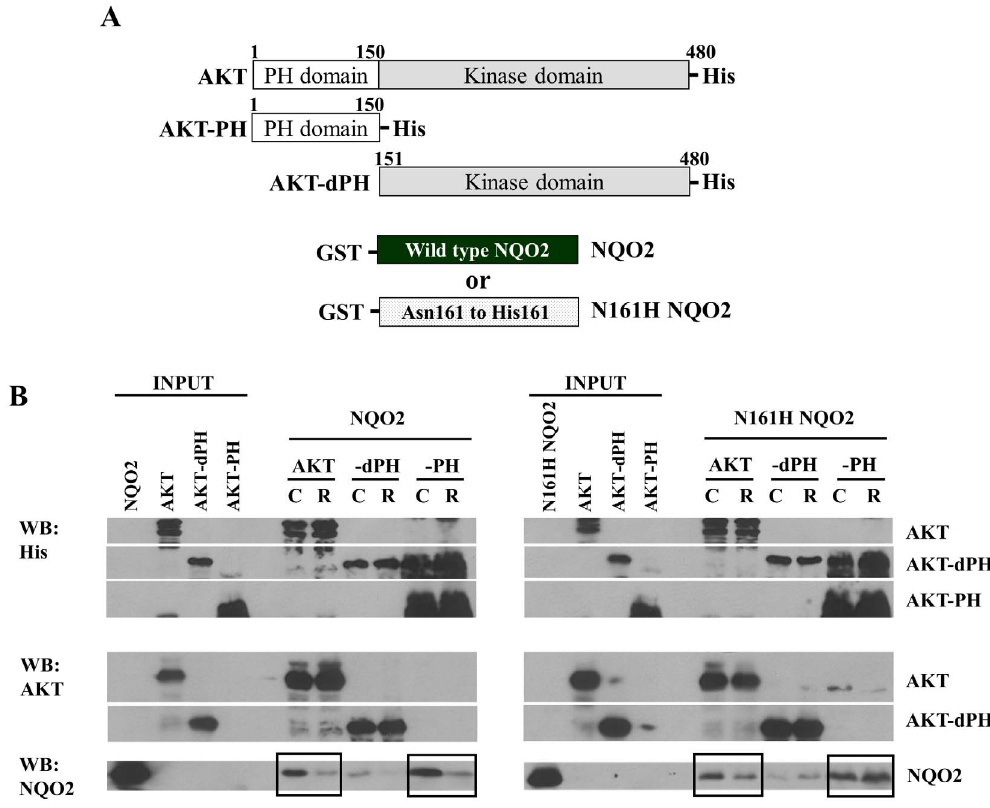
Figure 2. Effects of NQO2 on resveratrol mediated AKT control. ( A ) Mapping of the sites of NQO2 and AKT interaction using full-length and truncated deletion constructs of NQO2 and AKT, respectively. ( B ) Determination of the interactions between NQO2 and AKT by pull-down assays. His- AKT, His-AKT-dPH or His-AKT-PH (up to 2.5 m g) was used to pull down purified GST-NQO2 or GST-N161H NQO2. The bound proteins were subjected to 10% SDS-PAGE and then immunoblotted using monoclonal antibody against AKT, NQO2 or His. Conditions for C (control) and R (resveratrol) consisted of GST-tagged-NQO2 pre-incubated with or without 1 mM resveratrol added prior to performance of the pull down assays.